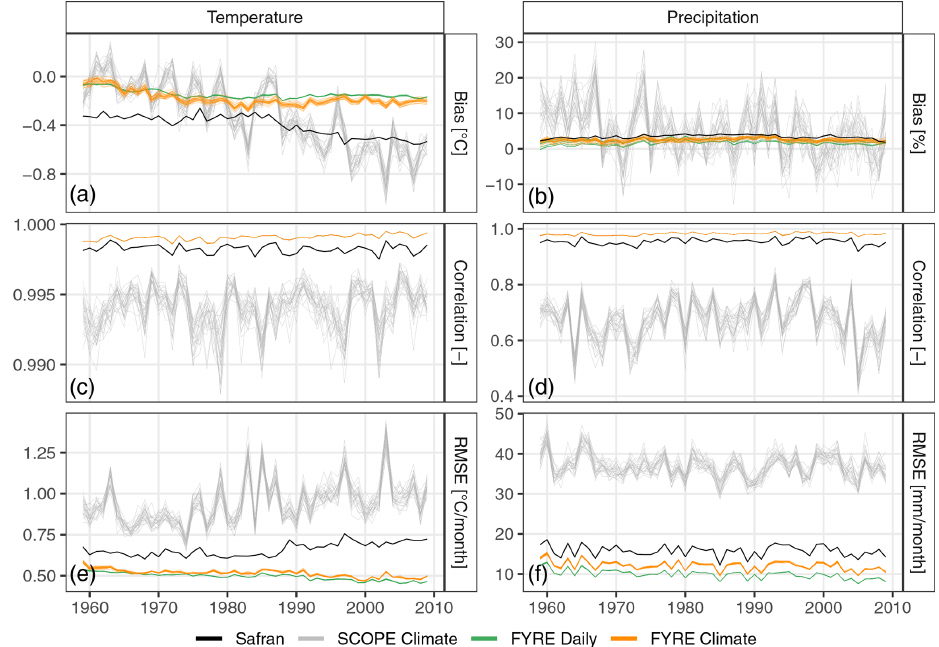
Figure 6. Evolution of the mean monthly bias (a, b) , correlation (c, d) and root mean square error (RMSE, e, f ) between the monthly homog- enized series and each member of SCOPE Climate/FYRE Daily/FYRE Climate/Safran for temperature (a, c, e) and precipitation (b, d, f) between 1959 and 2009. See text for details. Please note that the correlation curve of FYRE Daily is actually hidden by that of FYRE Climate.